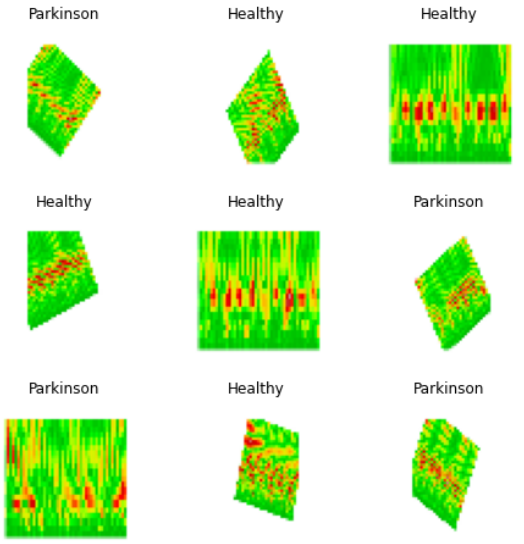
Figure 10. Batch sample of images used for model